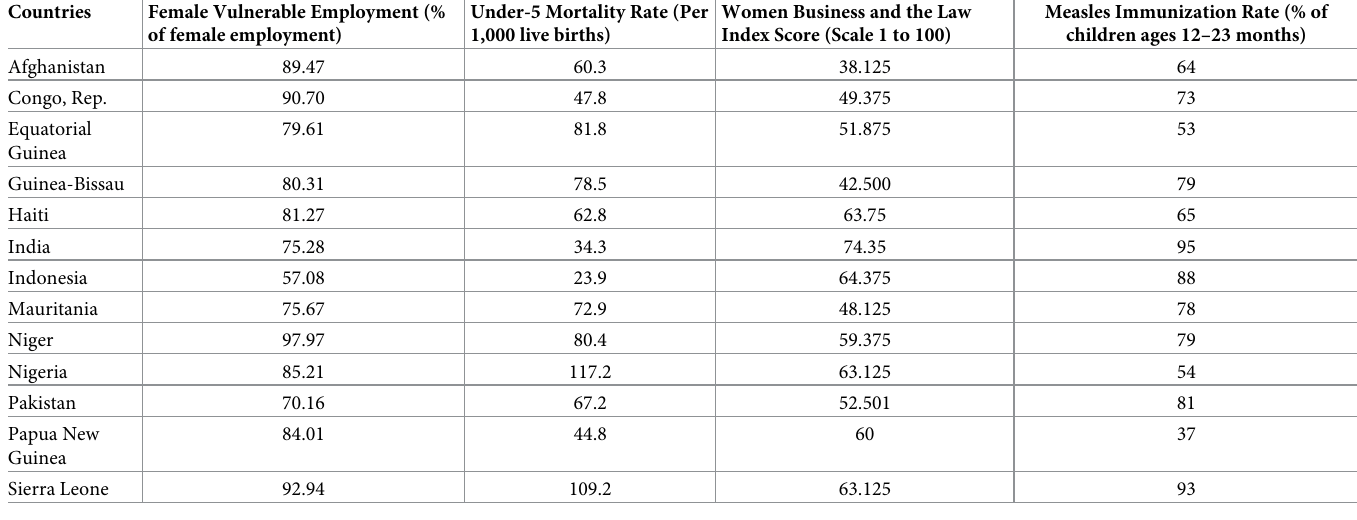
Table 1. A few facts about socio-economic sufferings leading to under-5 mortality rates. Countries Female Vulnerable Employment (% of female